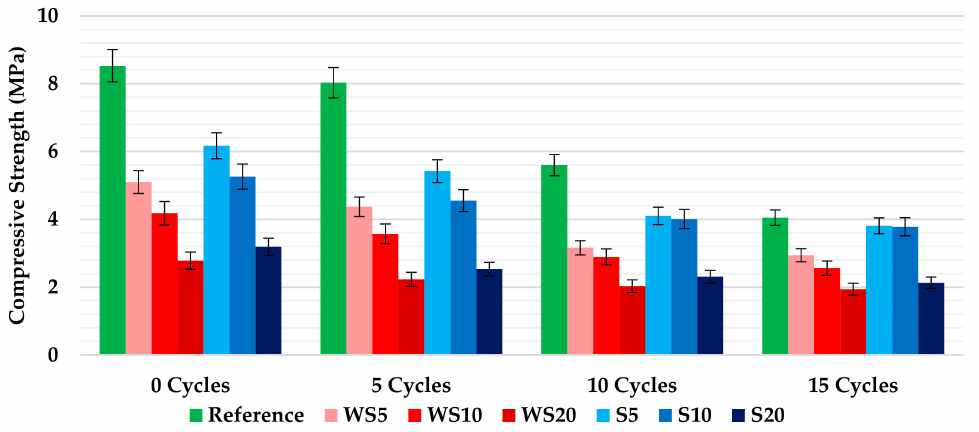
Figure 11. Compressive strength of the plasters after 0, 5, 10, and 15 wetting–drying